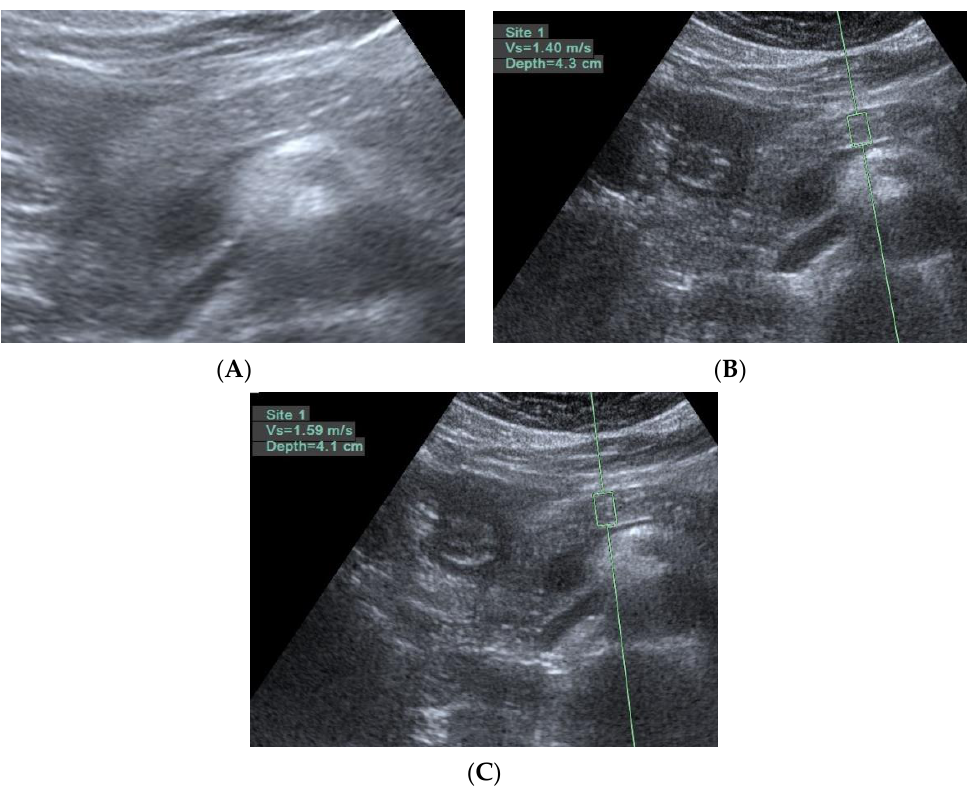
Figure 5. Three trans-abdomen sonographic images of the pancreas in the same patient. ( A ) Some hyperechoic foci in the pancreas; ( B ) if there are no hyperechoic foci in the region of interest, the pancreatic ARFI is 1.4 m/s; and ( C ) if there are hyperechoic foci in the region of interest, the pancreatic ARFI is higher (1.59 > 1.4 m/s).